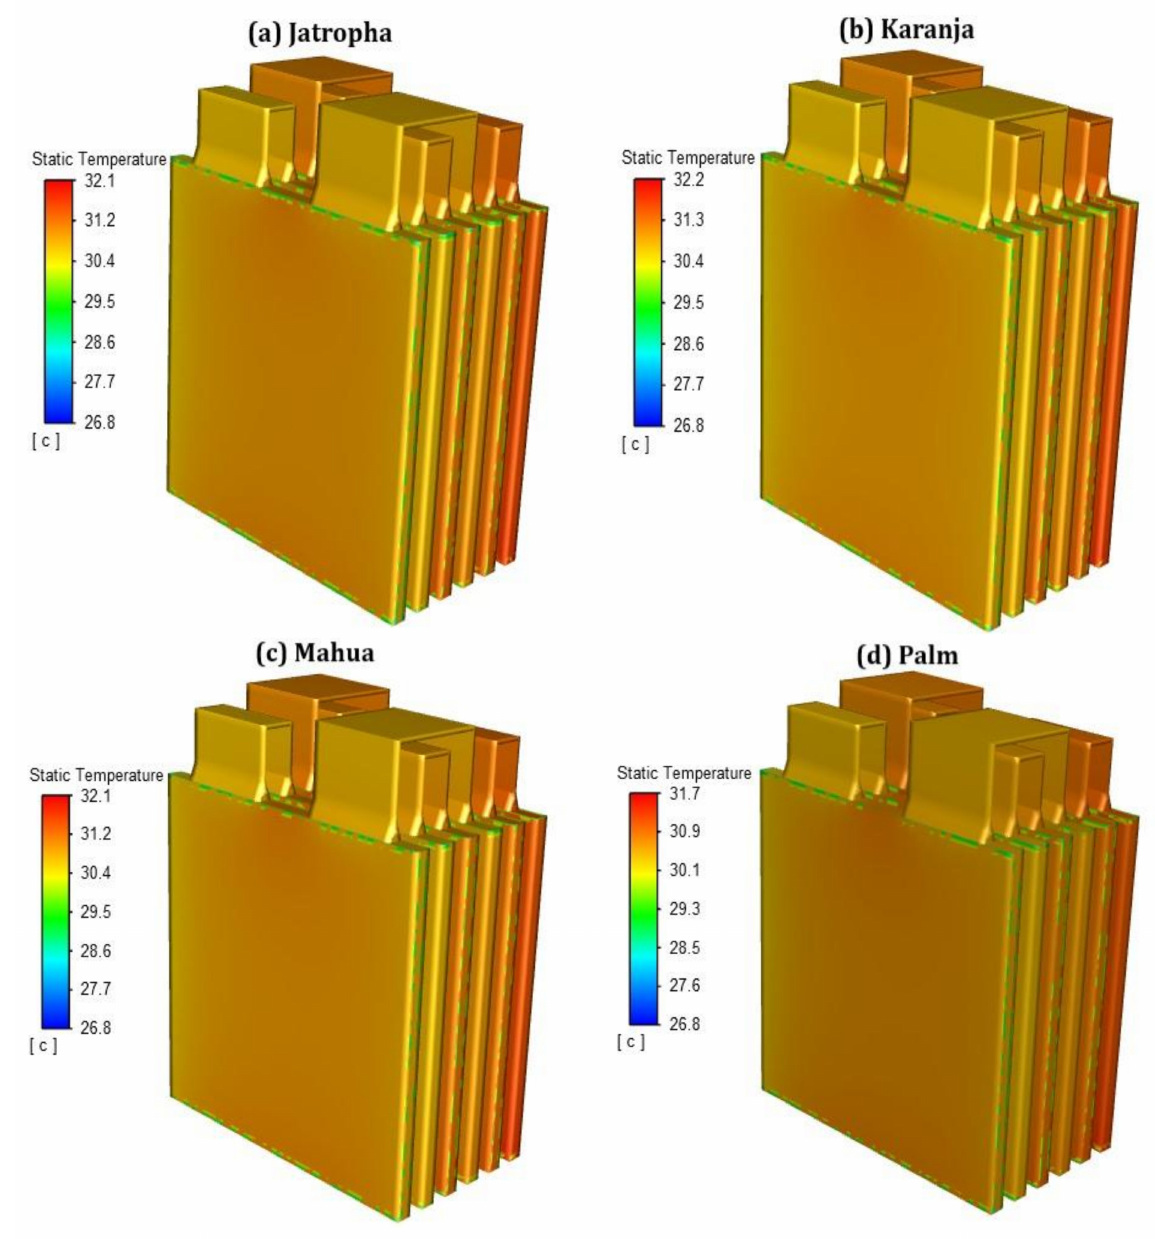
Figure 12. LIB module temperature distribution at 3C discharge rates using the biodiesel fuel of ( a ) jatropha, ( b ) karanja, ( c ) mahua, and ( d ) palm